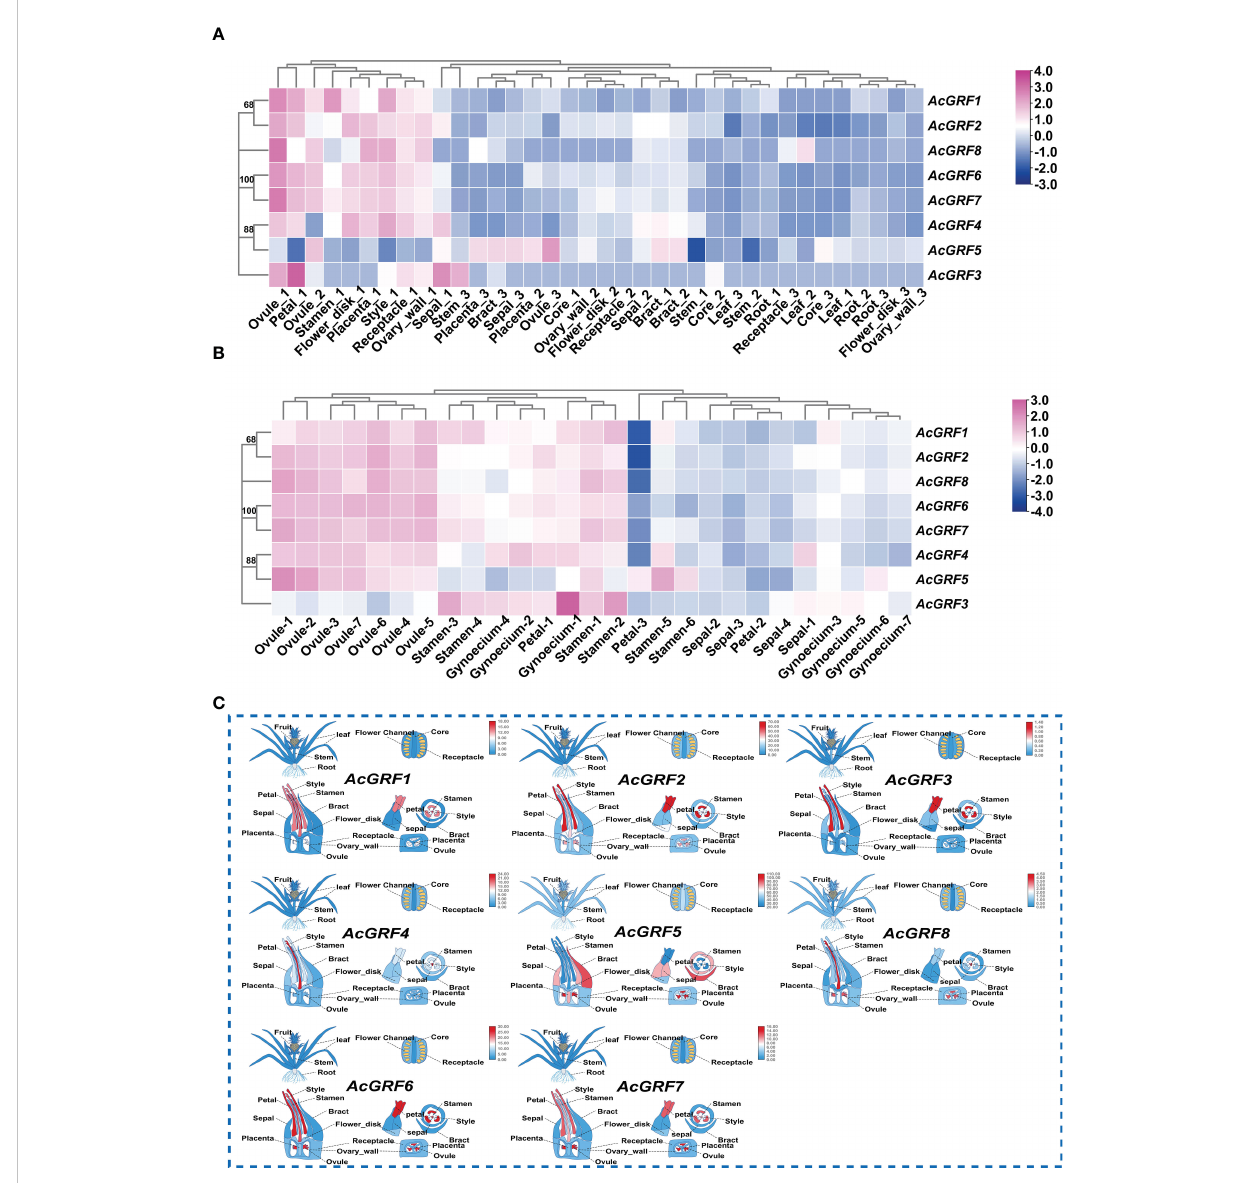
FIGURE 5 Expression of AcGRF genes in different tissues of pineapple. (A) Clustered heat map showing the expression patterns of AcGRF genes in various tissues at different developmental stages. (B) Expression heat map of AcGRF genes in fi ve fl oral organs (stamens, pistils, ovules, sepals, and petals) of pineapple at different developmental stages: four stages of sepals (S1 – S4), three of petals (S1 – S3), fi ve of stamens (S1 – S5), and seven of pistils (S1 – S7) and ovules (S1 – S7). Relative gene expression is quanti fi ed as log 2 (FPKM+1). Blue, white, and red indicate low, medium, and high expression levels. (C) Cartoon heatmap showing the expression patterns of AcGRF genes from different clades in different